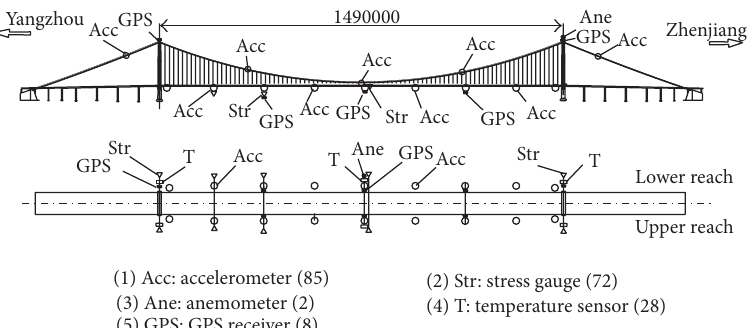
Figure 6: Layout of sensor system of RSB (dimension unit: mm).